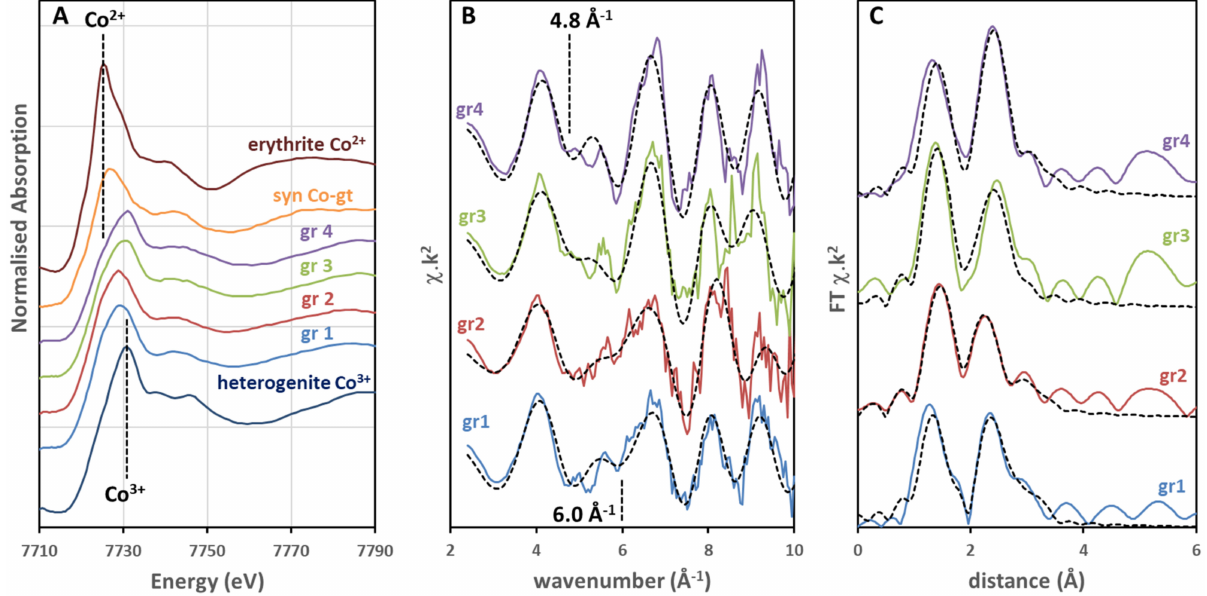
Figure 16. ( A ) Co K-edge XANES spectra of standards heterogenite, erythrite and synthetic Co- doped goethite plotted with those for 4 asbolane-lithiophorite grains. ( B ) EXAFS spectra for the same asbolane-lithiophorite intermediates points as shown in ( A ). ( C ) Fourier transforms of the Co EXAFS spectra from ( B ). Dashed lines in ( B , C ) are the modelled fits to the experimental data (solid